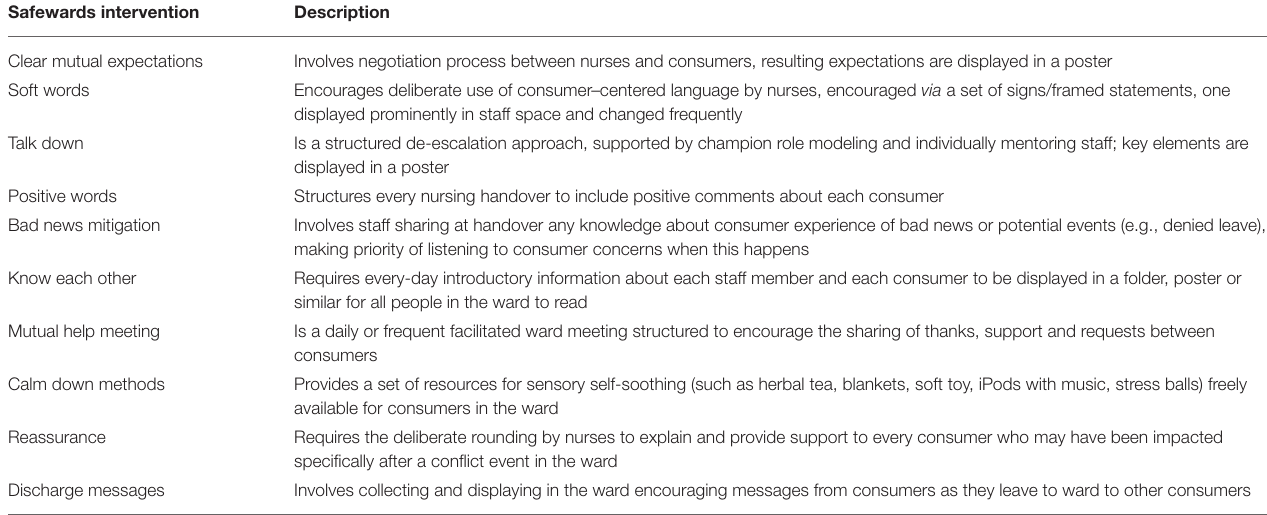
TABLE 1 | Description of the 10 Safewards interventions (25). Safewards